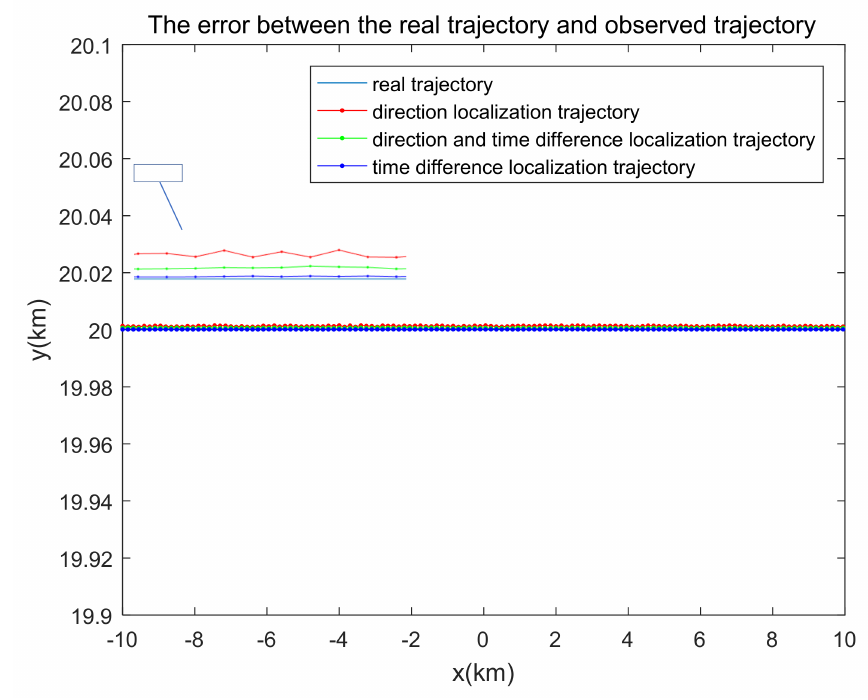
Figure 13. Observation errors in each cooperative localization approach.